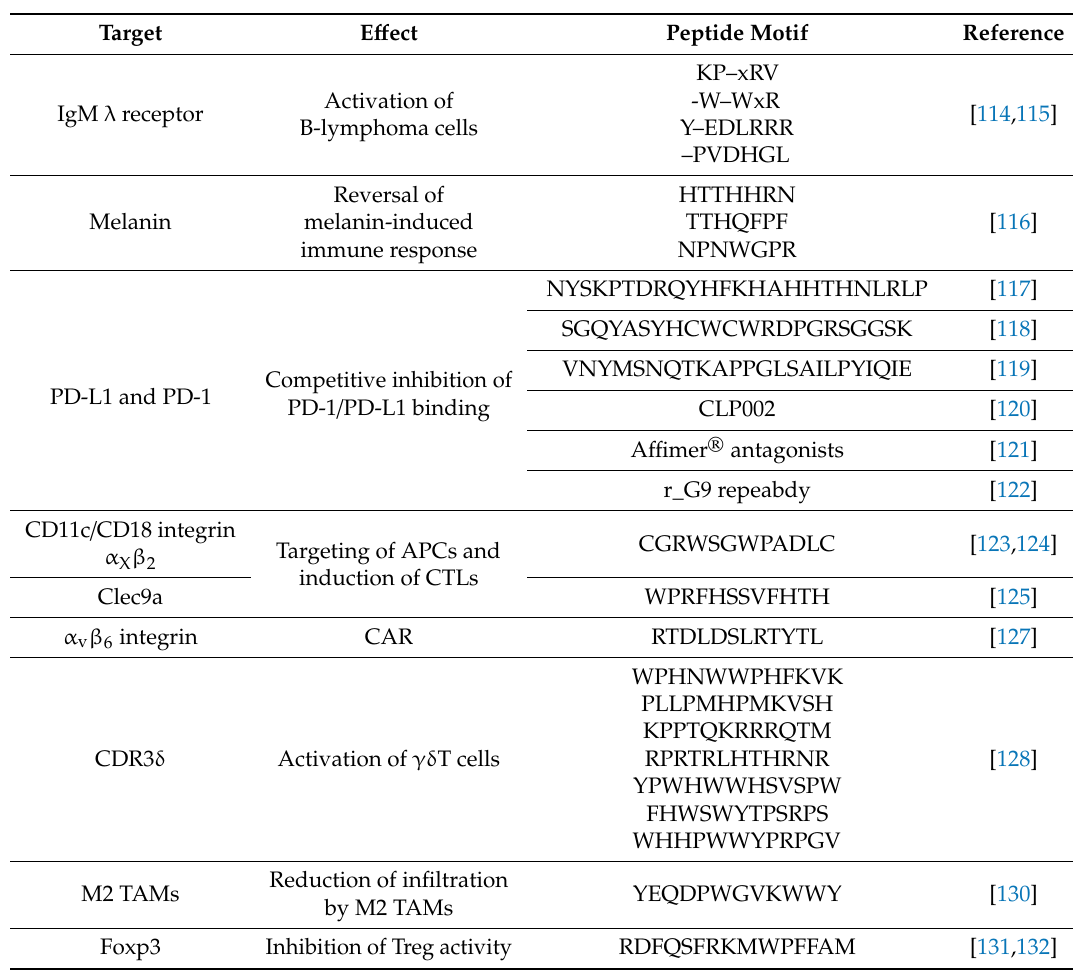
Table 3. Phage display-derived peptides as direct nanomodulators of the immune